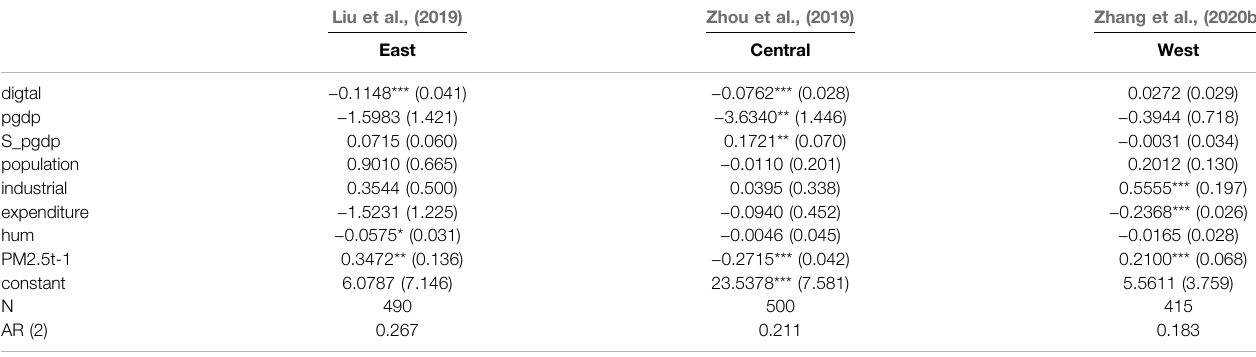
TABLE 4 | Results of heterogeneity test.